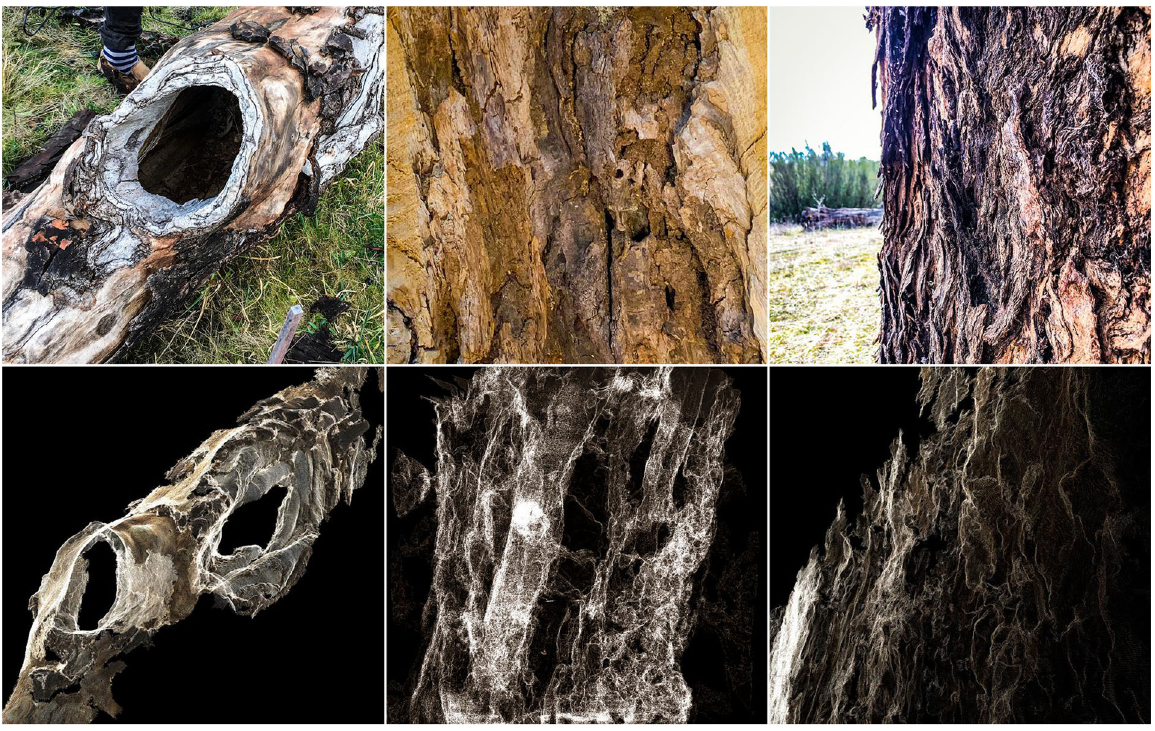
Fig. 8 Hollows and bark. Top: samples. Bottom: imaging outputs. Left: yellow box ( Eucalyptus melliodora ) tree hollow imaged with structured light photogrammetry. Middle: the internal surface of a hollow imaged with computed tomography. Right: rough bark of a yellow box imaged with structured light photogrammetry (Source: the